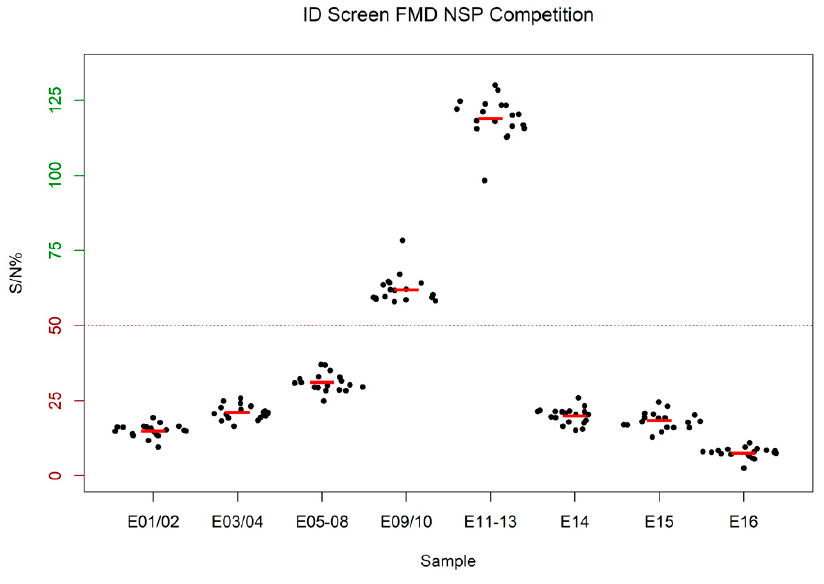
Figure 2. Results of the ID Screen FMD NSP Competition ELISA. The mean value of all results of each participant for a sample group is shown as a single filled black circle. The mean of means for all participants for each sample group is represented by a red bar. Samples with an optical density less than or equal to 50 % of the optical density of the negative control (S/N% ≤ 50) are considered positive. See Table S2 in the supplemental material for the raw data summarized in this figure.